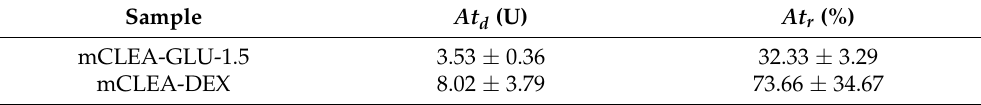
Table 5. Effect of the cross-linking agent on the magnetic cross-linked enzyme aggregates (mCLEAs) parameters of β -galactosidase: Immobilized enzyme activity ( At d ) and Recovered activity ( At r ).